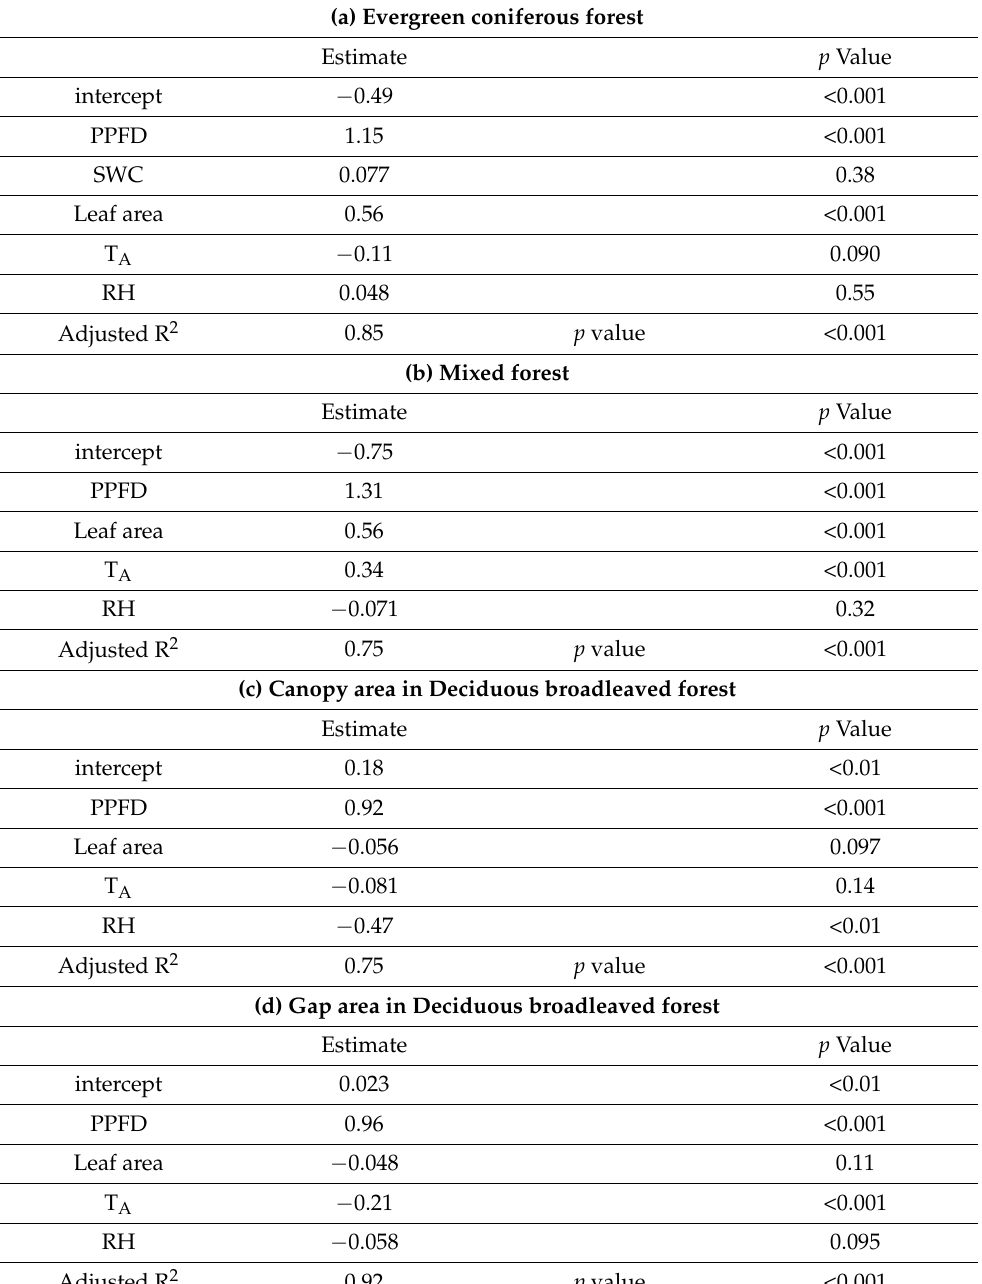
Table 3. Results of multiple regression analysis to elucidate factors that control the seasonal trends of the Sasa community GPP in the four